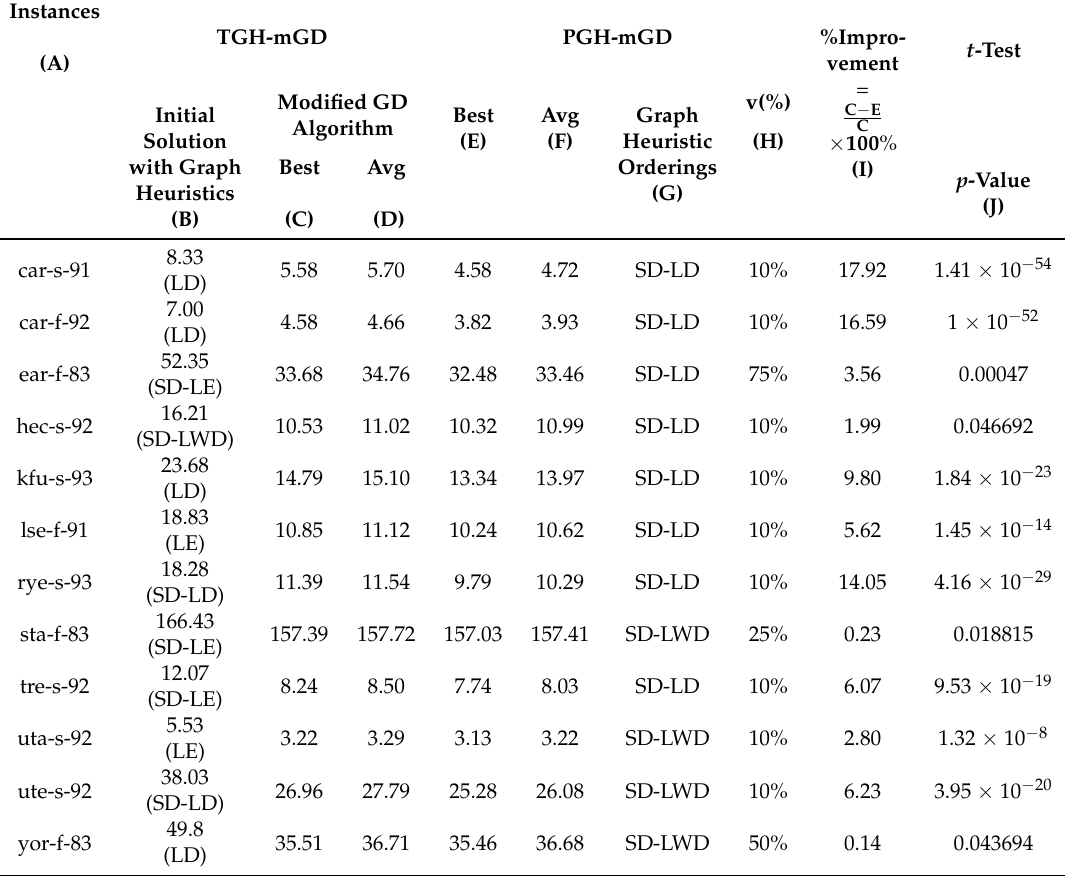
Table 5. Comparisons of results between TGH-mGD and PGH-mGD for Toronto